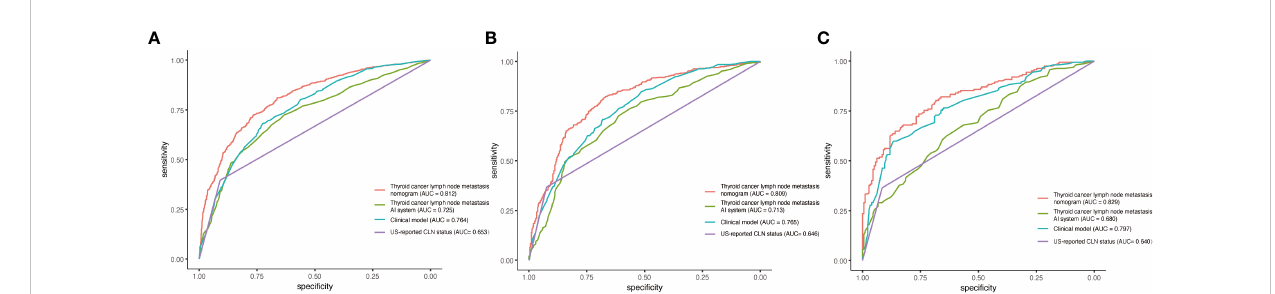
FIGURE 3 Performance of the thyroid cancer lymph node metastasis nomogram, thyroid cancer lymph node metastasis AI system, clinical model and US- reported CLN status in PTC patients. (A) ROC curve for predicting CLNM in the training cohort. (B) ROC curve for predicting CLNM in the internal validation cohort. (C) ROC curve for predicting CLNM in the external validation cohort.